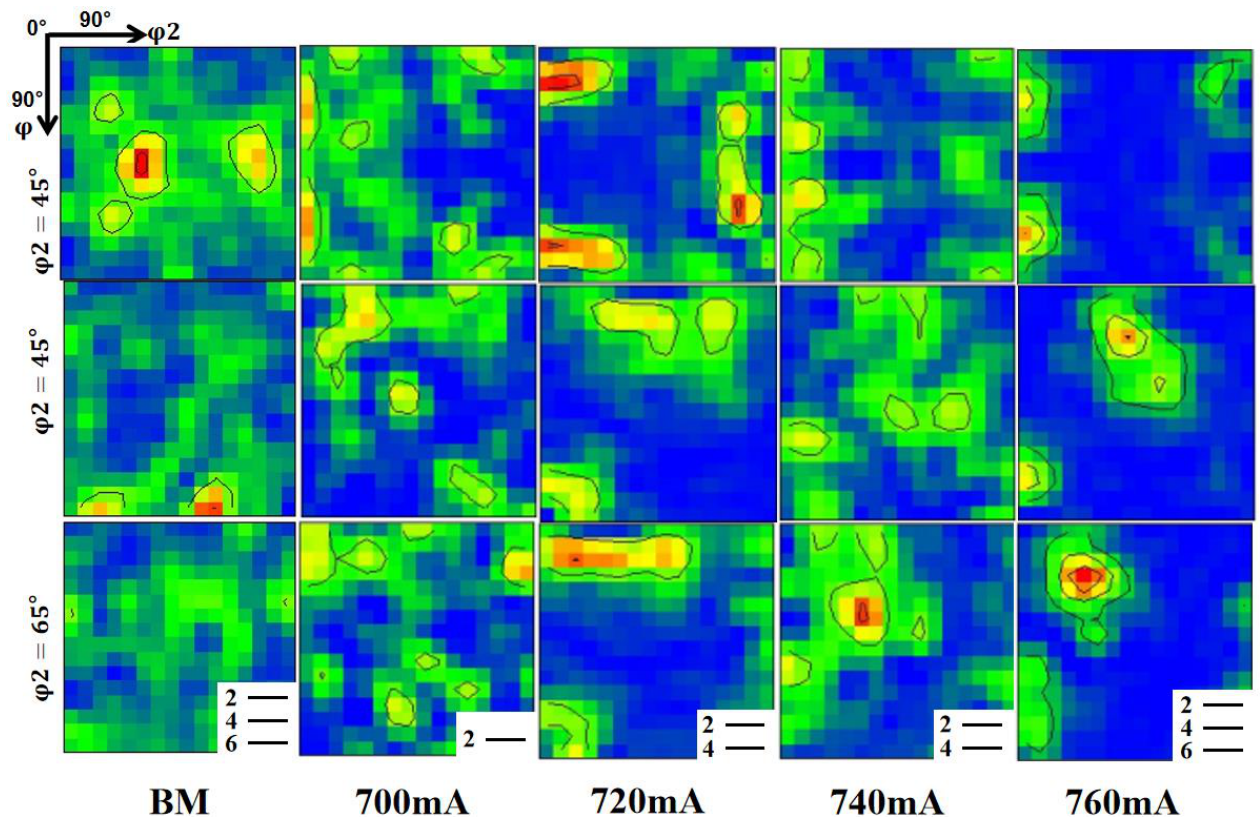
Figure 11. Distribution of austenite texture of Inconel 625 base material and specimens after 700 mA to 760 mA electron beam scanning.